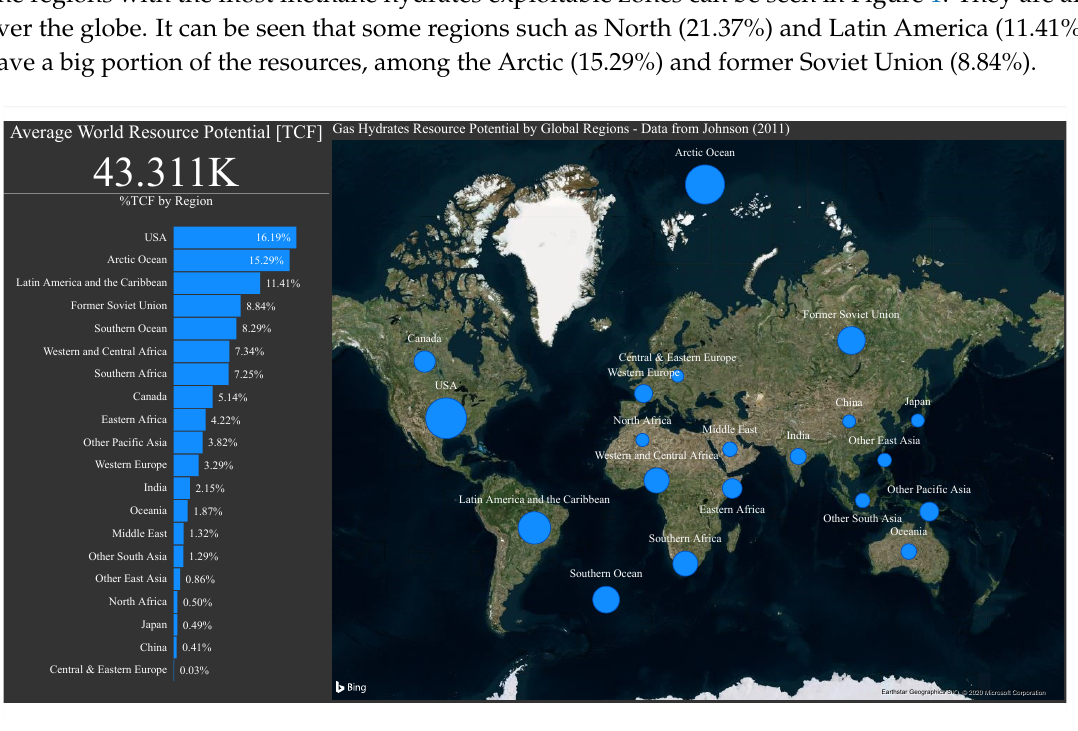
Figure 1. Methane hydrates resource potential by global regions [TCF]—Data from Johnson (2011)